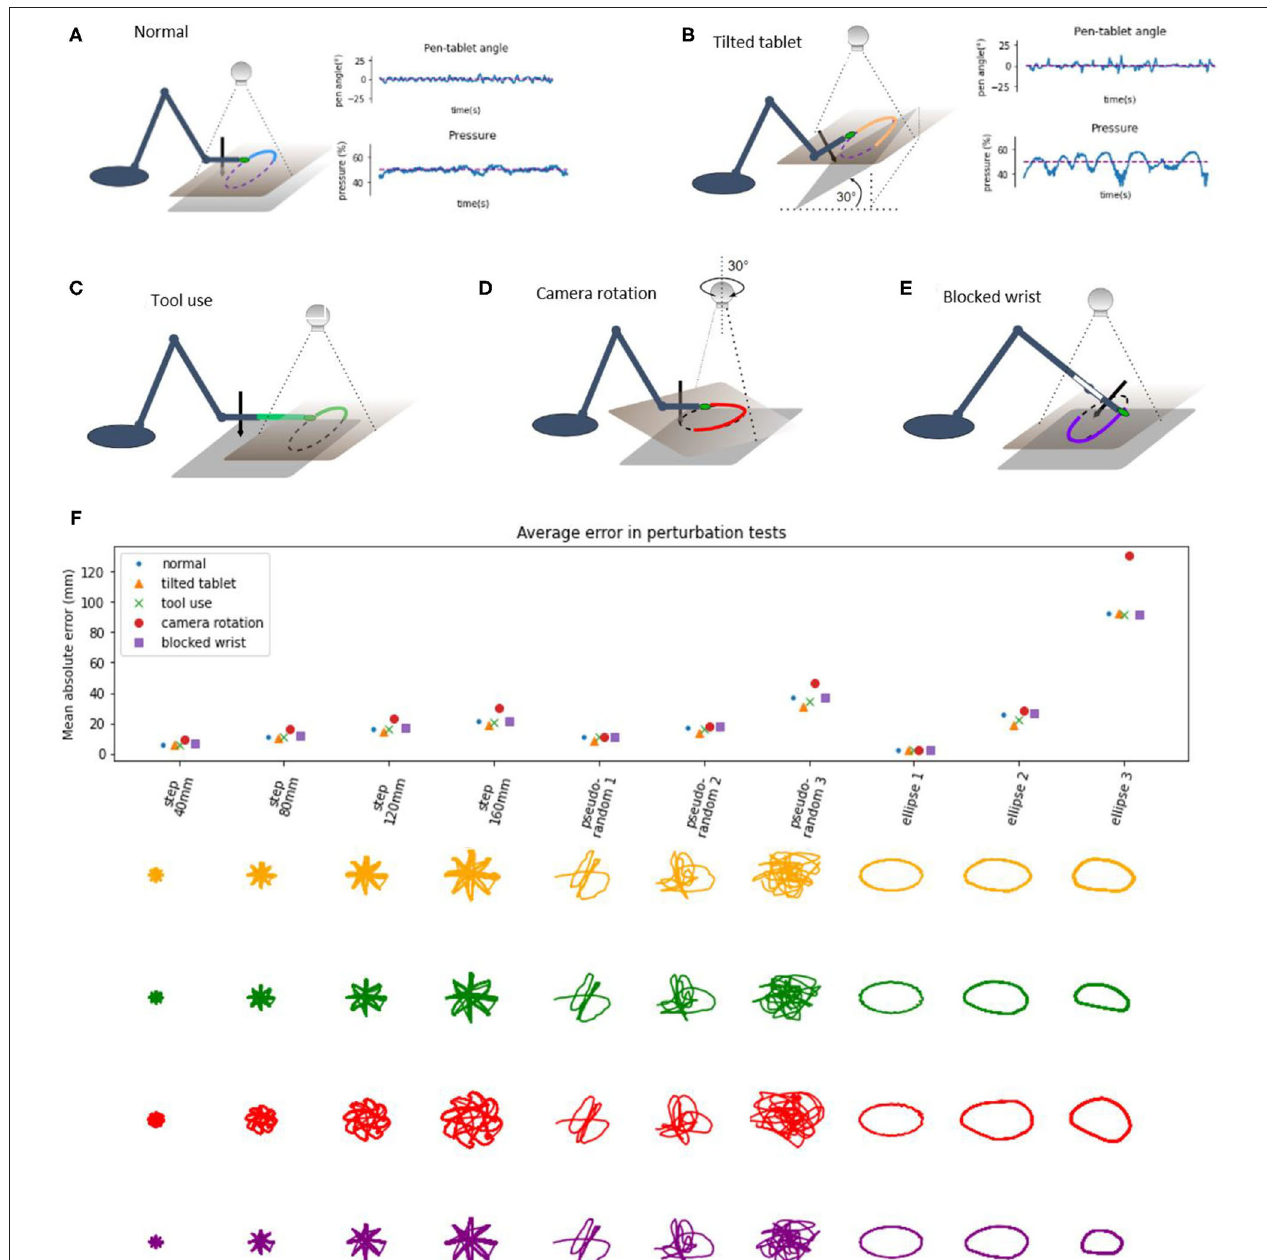
FIGURE 7 | Diagrams of perturbation conditions and a plot of tracking performance in different tasks. (A) the normal condition diagram and plots of pen angle and pressure from a pseudorandom tracking task, reference in red and measured variable in blue. (B) The tablet is tilted 30 ◦ , distal part is lifted, plots show the pen angle, and pressure in a pseudorandom tracking task, reference in red and measured variable in blue. (C) Diagram of the tool use task, a 12cm plastic piece is attached to the hand of the robot, and the maker placed on the end. (D) Diagram of the camera rotation task; the camera is rotated by 30 ◦ when compared to the “normal” conditions. (E) Diagram of the blocked wrist. (F) Average distance (absolute error) between the marker and the reference in the visual space, across different conditions and tracking tasks. Bellow the plot are robot trajectories for each perturbation condition and